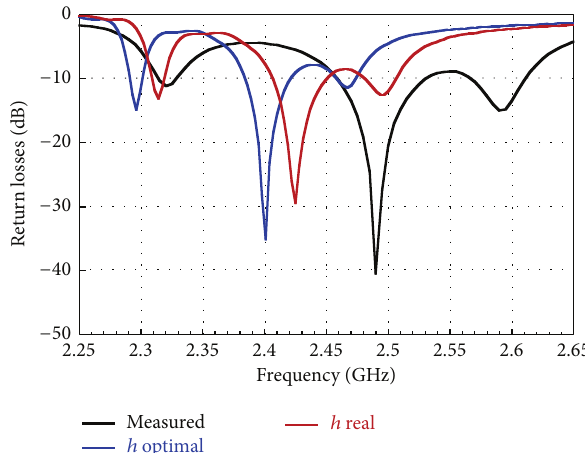
Figure 16: Return losses (antenna with sharp